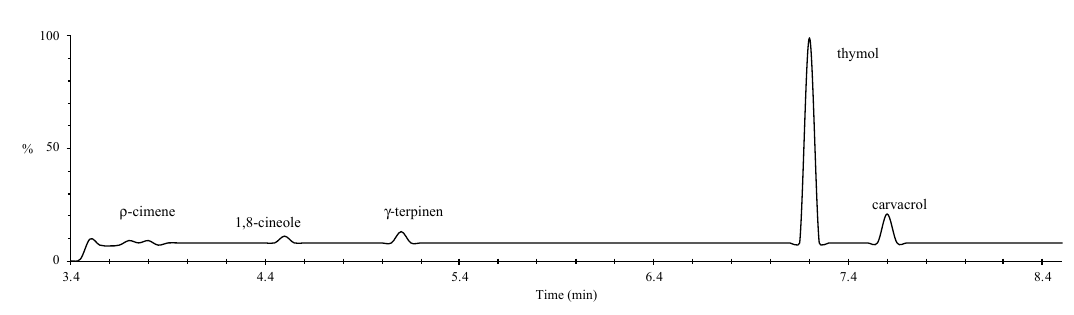
Figure 1. Mass spectra of Mexican oregano (Lippia berlandieri Schauer) essential oil.